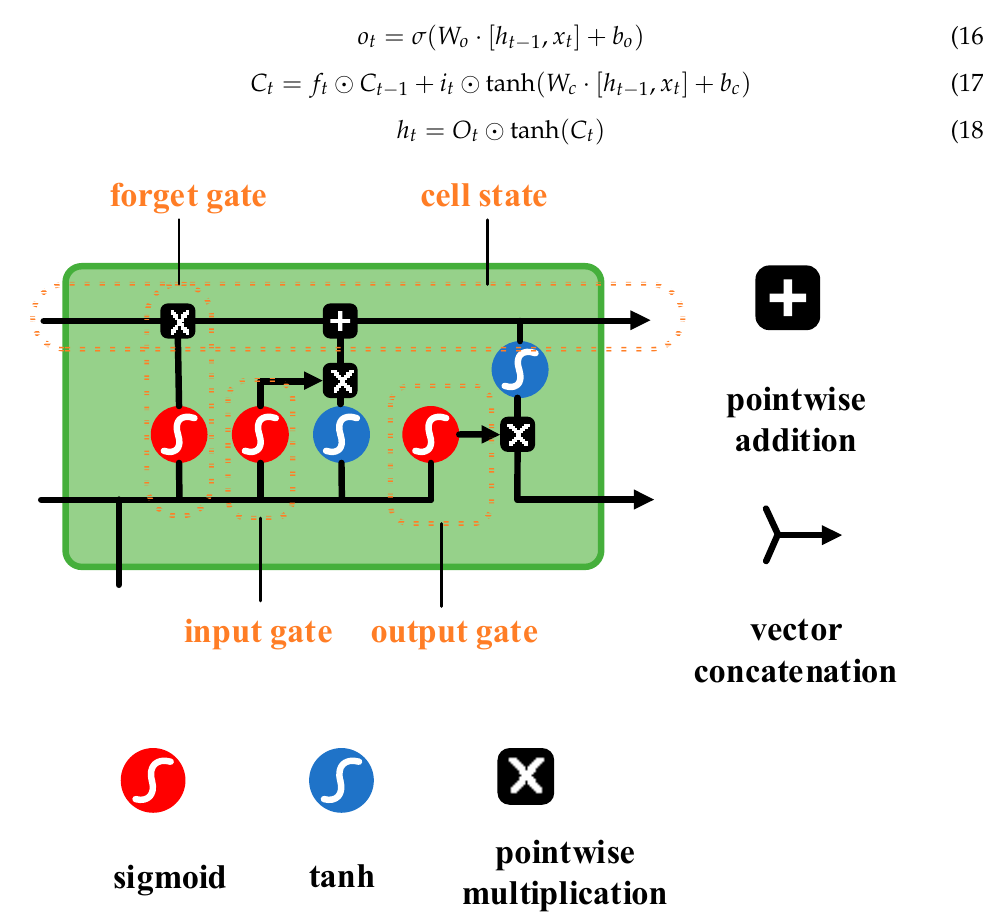
Figure 3. The structure of a LSTM cell.